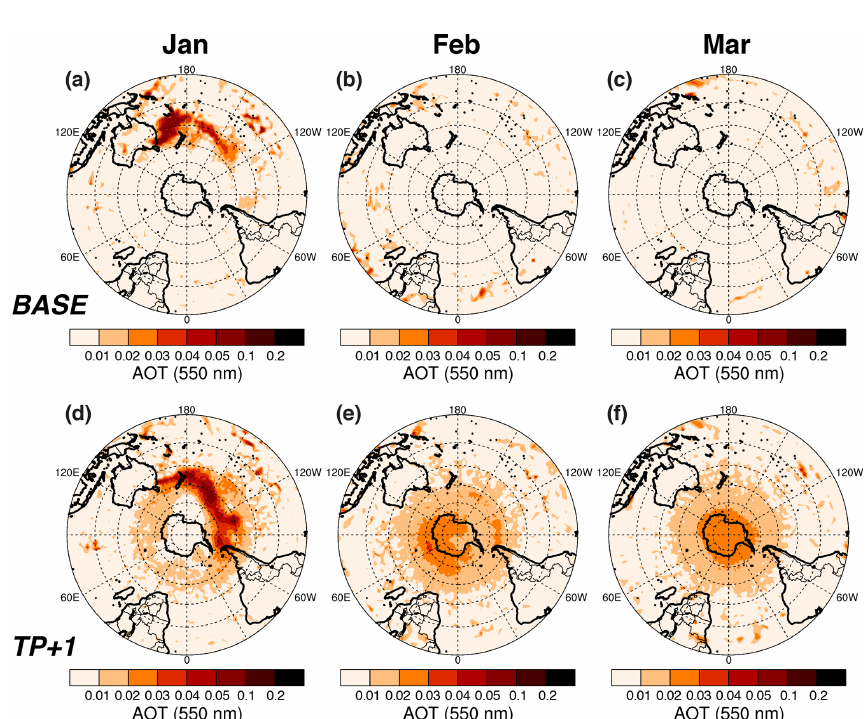
Figure 2. Monthly mean simulated AOT differences for January to March 2020 for the cases BASE − NoEmiss (a–c) , showing the contribu- tion of smoke AOT for the case when no smoke injection by pyroconvection is prescribed in the model, and TP + 1 − NoEmiss (d–f) , showing the effect on AOT of smoke injection into the model layer above the tropopause for the pyroCb days 29–31 December 2019 and 4 January 2020 in southeastern